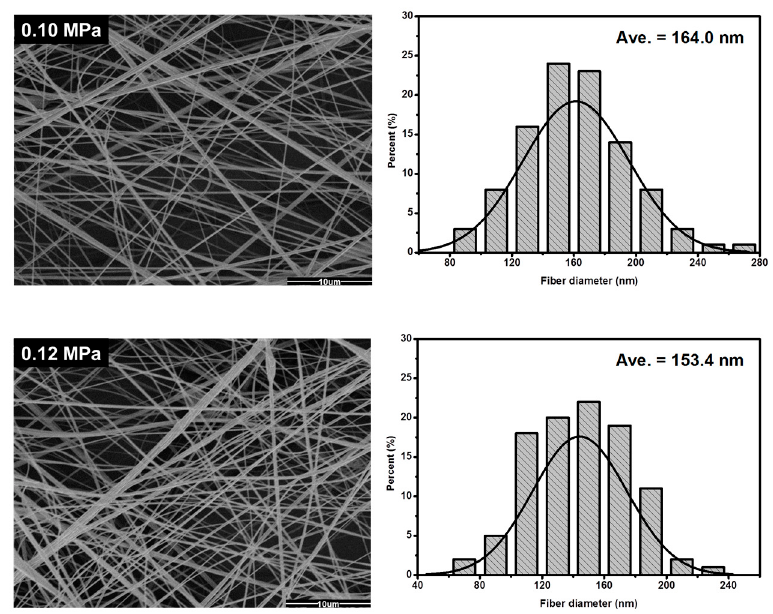
Figure 3. SEM micrographs and diameter distributions of solution blown PAA nanofibers at different gas pressure. PAA concentration, solution feeding rate, inner nozzle diameter and receiving distance were fixed as 8 wt %, 2.4 mL/h, 0.4 mm and 20 cm, respectively.